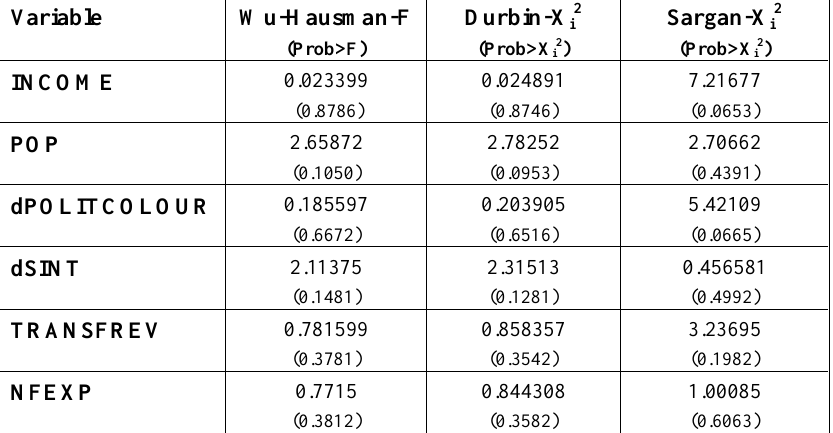
Table 3 : Analysis of potential endogeneity (Wu-Hausman and Durbin)*